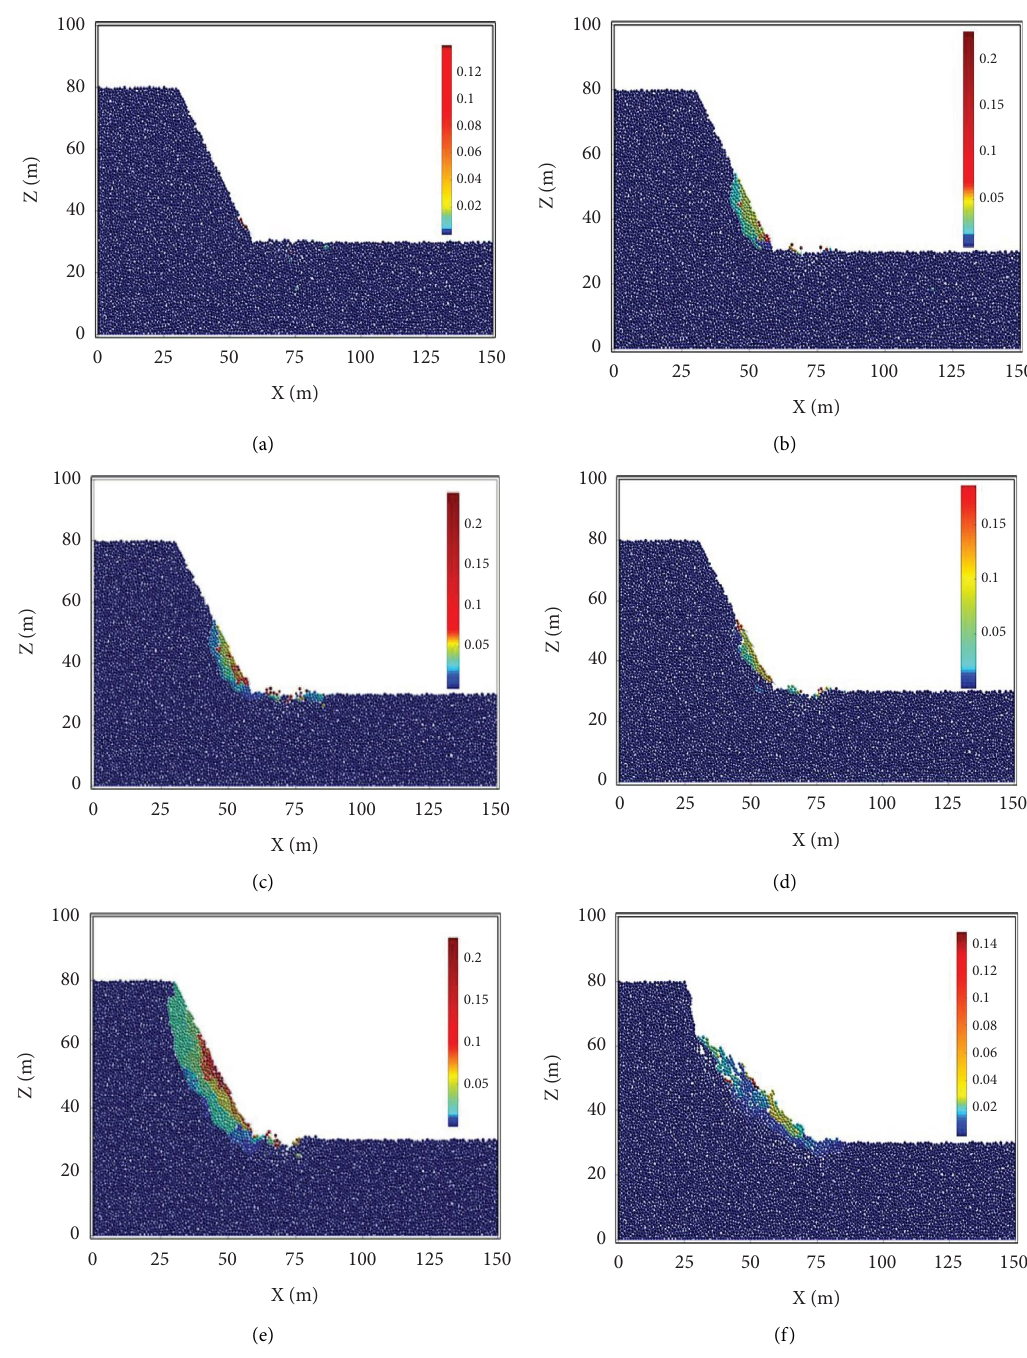
Figure 8: Te efects of diferent ramming times on slope under the tamping energy of 10000kN · m. (a) Te frst time ramming; (b) the second time ramming; (c) the third time ramming; (d) the fourth time ramming; (e) the ffth time ramming; (f) the failure state of